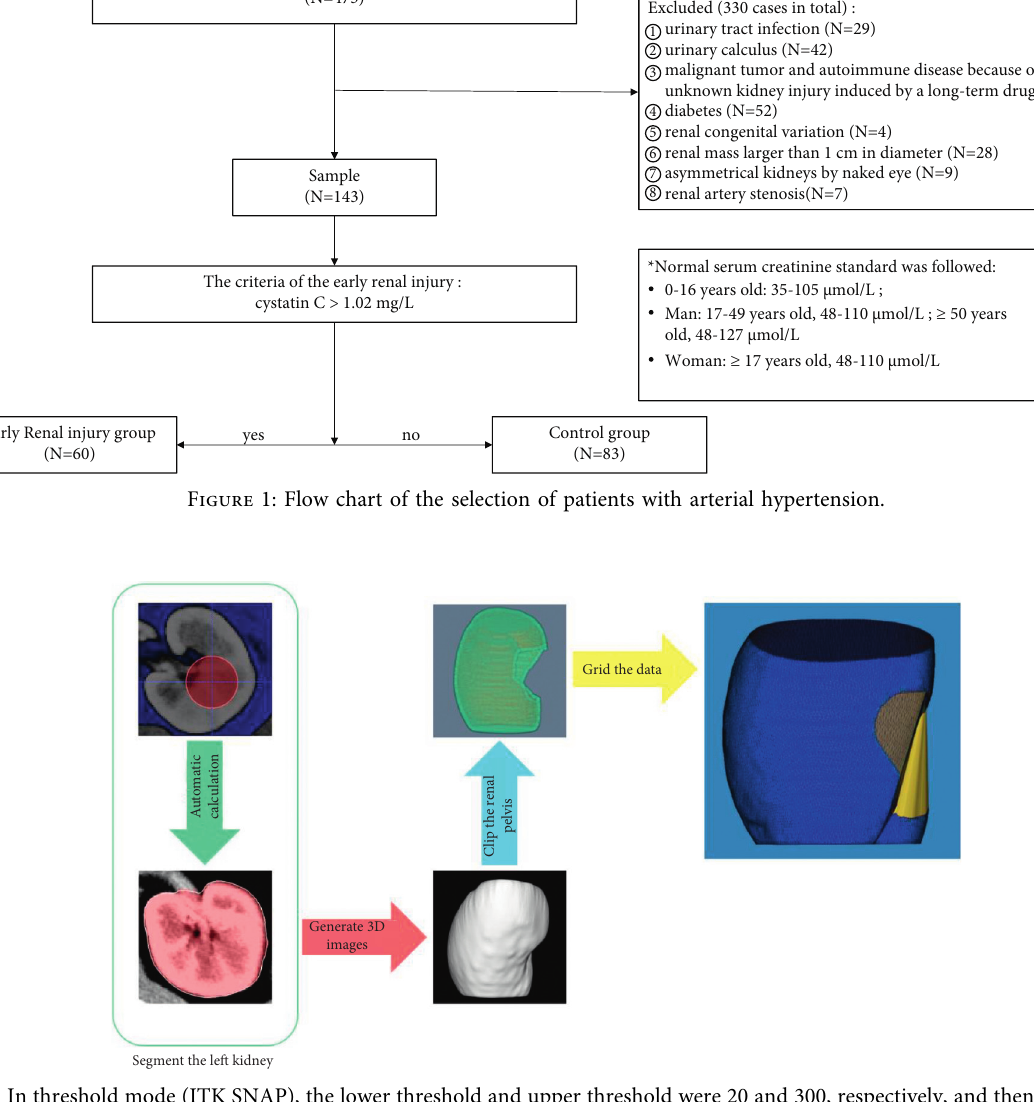
Figure 2: In threshold mode (ITK SNAP), the lower threshold and upper threshold were 20 and 300, respectively, and then an aspherical bubble was placed within the renal parenchyma on CT images. The regional competition force and smoothing force were 0.900 and 0.300, respectively, to automatically segment the left kidney (red area). Three layers of images (15 mm in thickness) at the upper and lower poles of the left kidney were then removed. 3D images of the kidney were generated. Afterwards, the renal pelvis was clipped. Finally, the data were gridded [15].